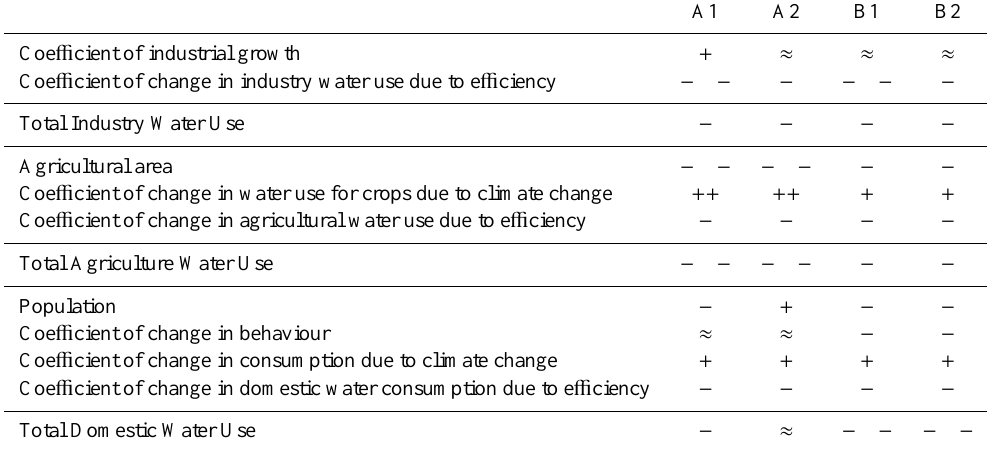
Table 1. Main trends in the various forcing factors for water use for each scenario. Legend: ( + ) indicates an increase, ( ++ ) indicates a substantial increase, ( ≈ ) indicates no change or very small changes, (–) indicates a decrease; (– –) indicates a substantial decrease. A1 A2 B1 B2